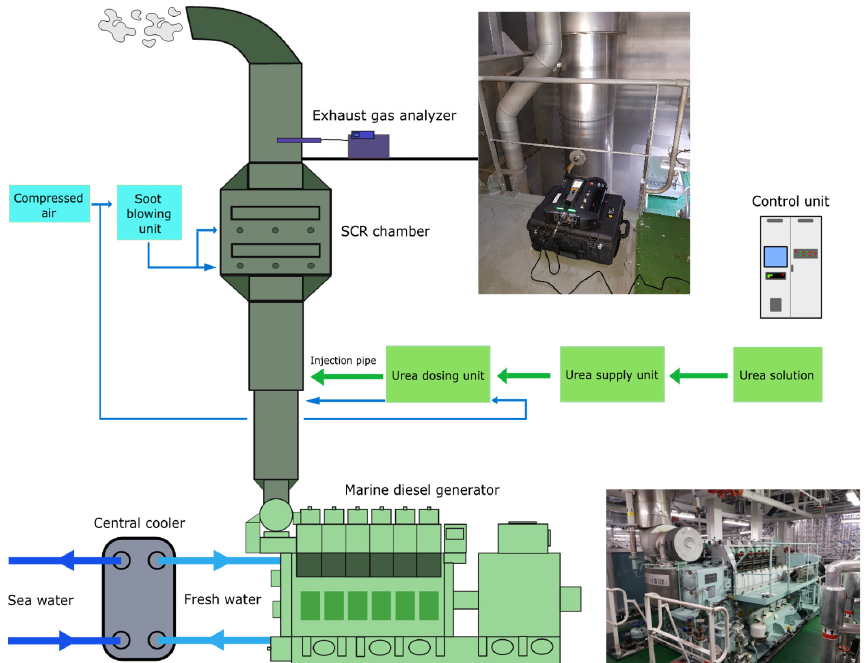
Figure 1. Schematic diagram of the experimental